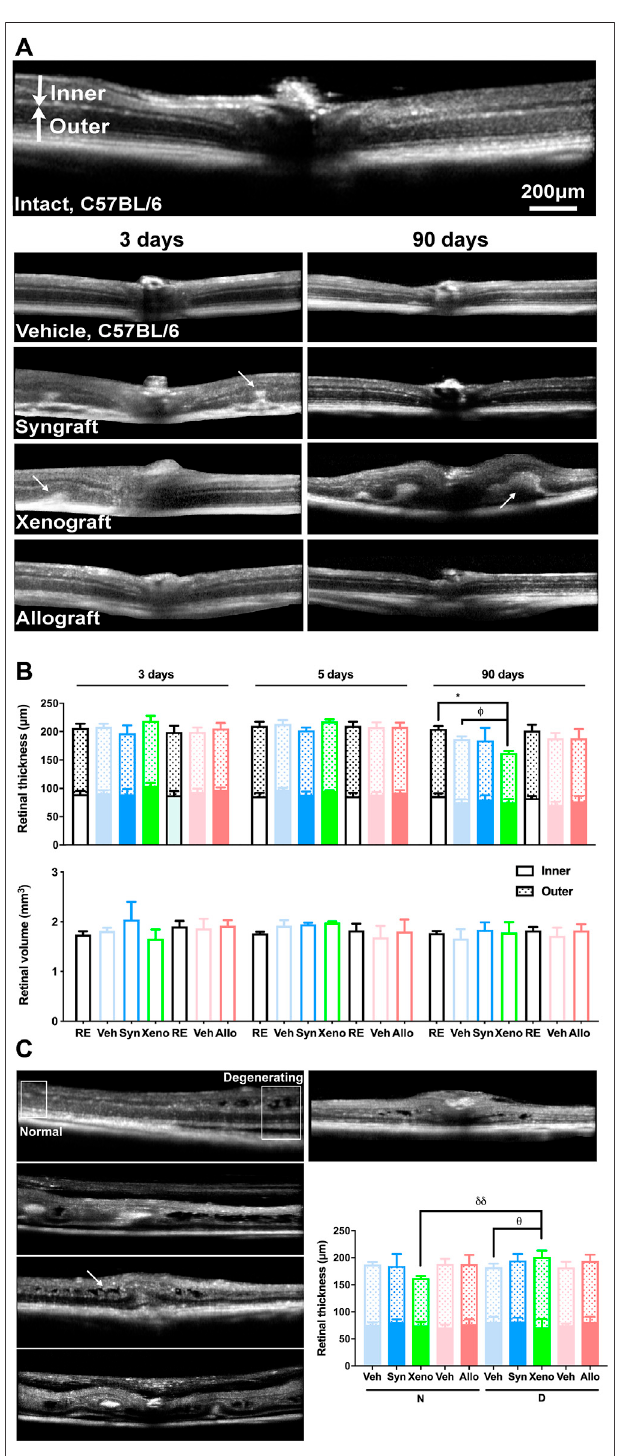
FIGURE 4 | Xenotransplant causes retinal edema, detachment, and thinning. (A) : In vivo OCT sections spanning the optic nerve in control (RE, 5 months old mouse), vehicle, and transplanted retinas analyzed at 3 or 90 days post-ONC. Intact and vehicle images are from C57/Bl6 mice because there was no difference between the recipient strains. In syngrafted and xenotransplanted retinas there were hyper-re fl ective areas below the